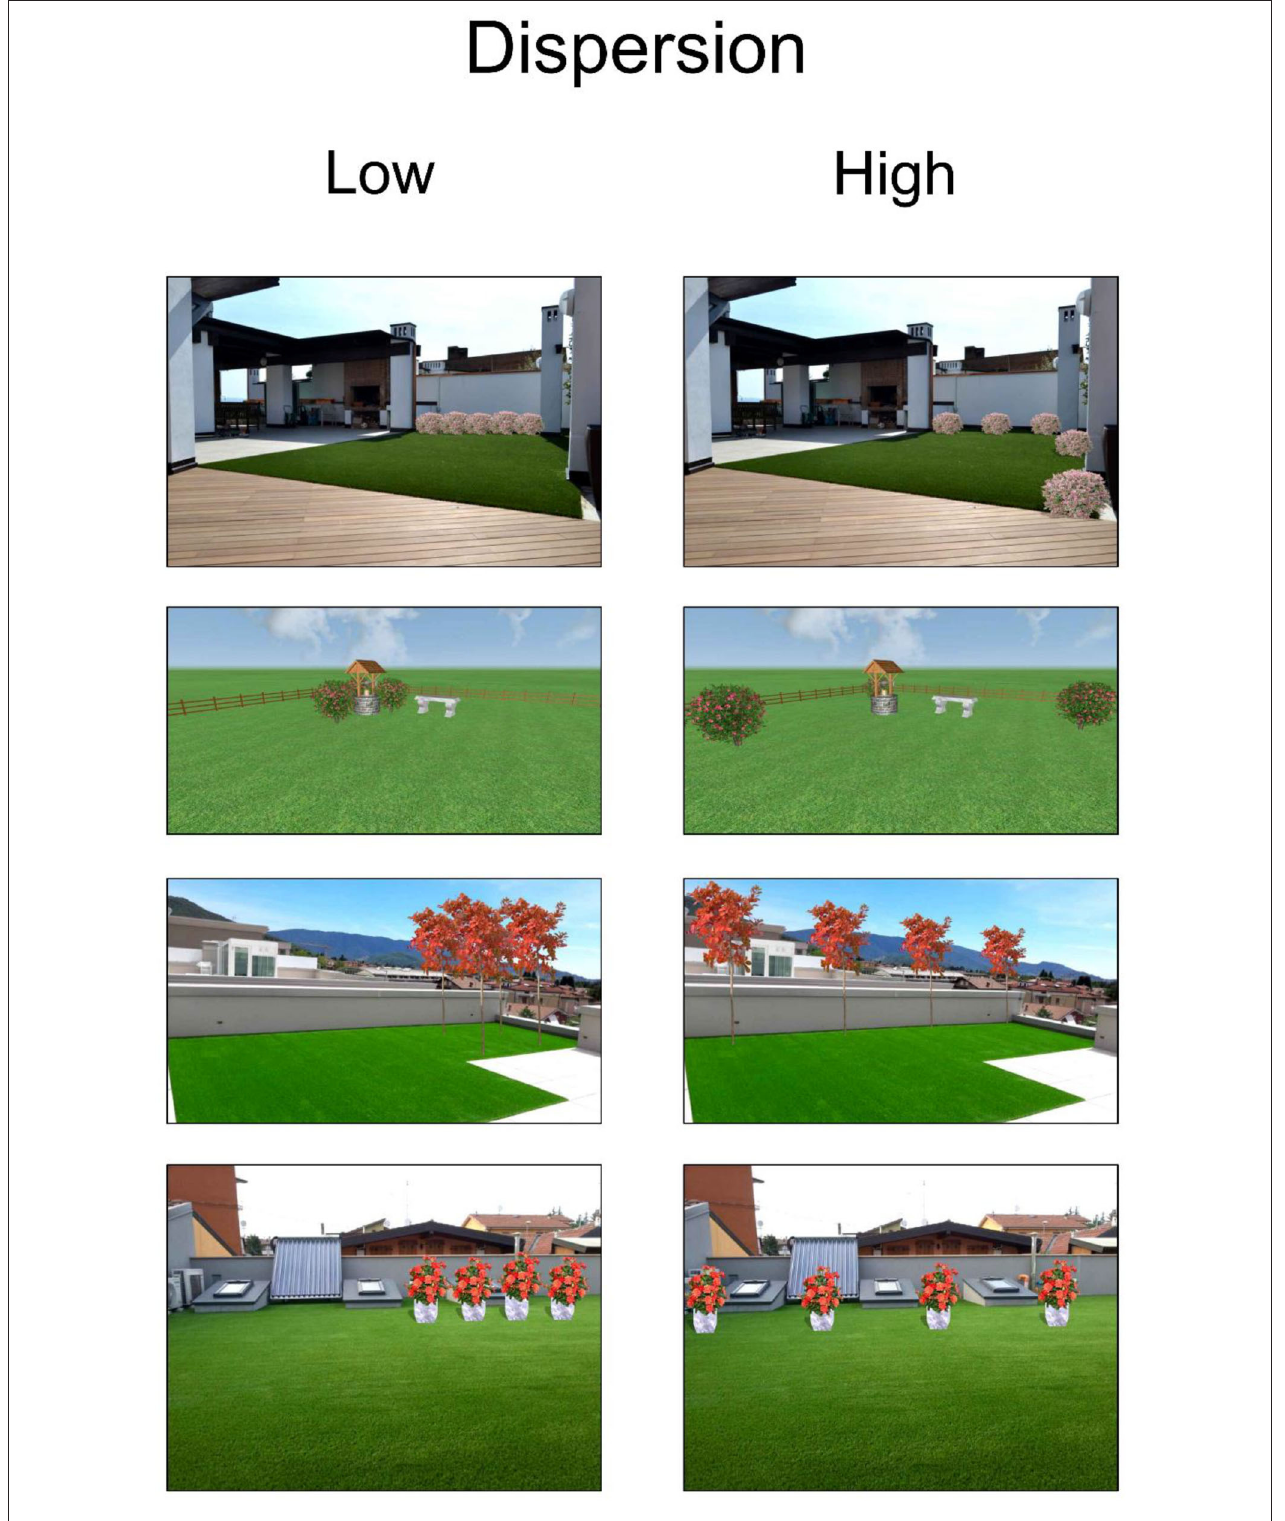
FIGURE 1 | Examples of landscape pairs varying for plant dispersion. Images created with Realtime Landscaping Architect. Reproduced with permission.